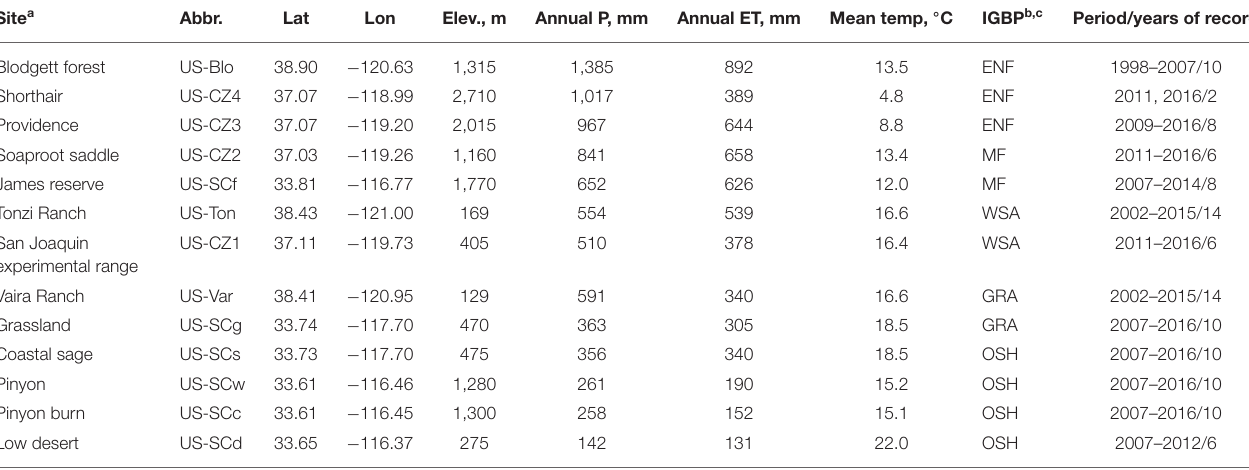
TABLE 1 | Site characteristics.